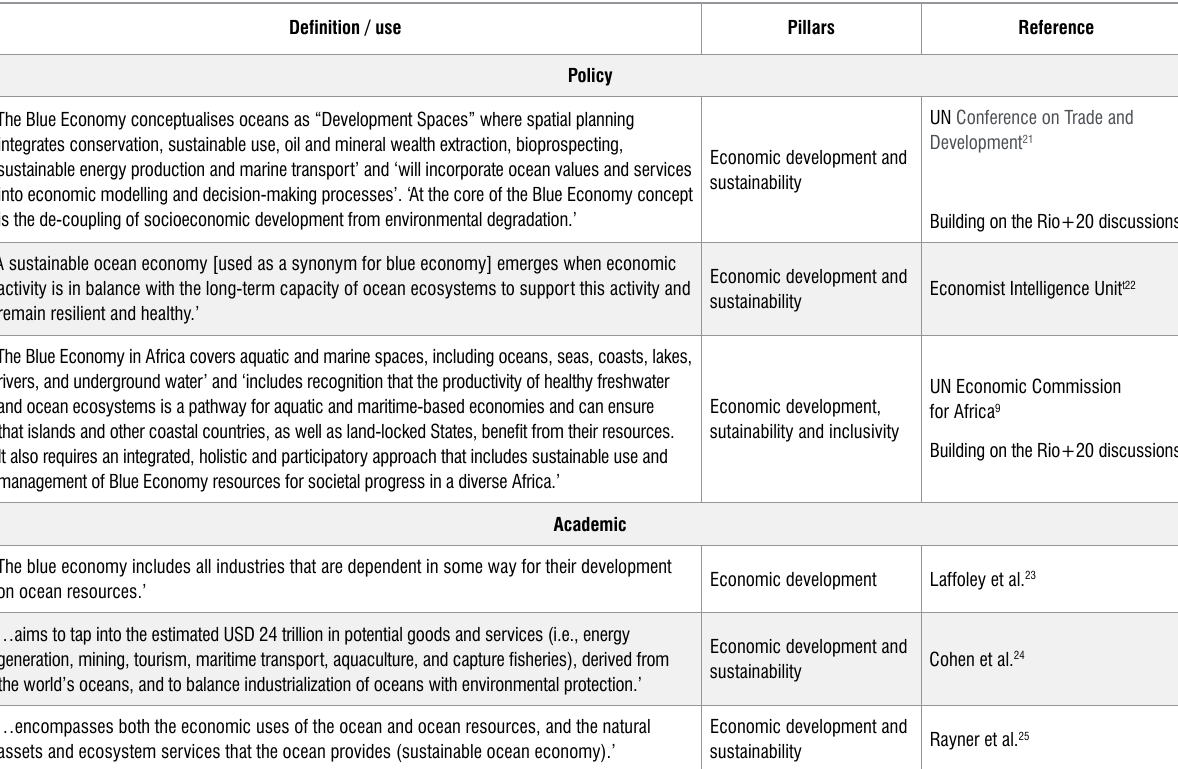
Table 1: Examples of the development and use of the term ‘blue economy’ in the policy and academic literature Definition /